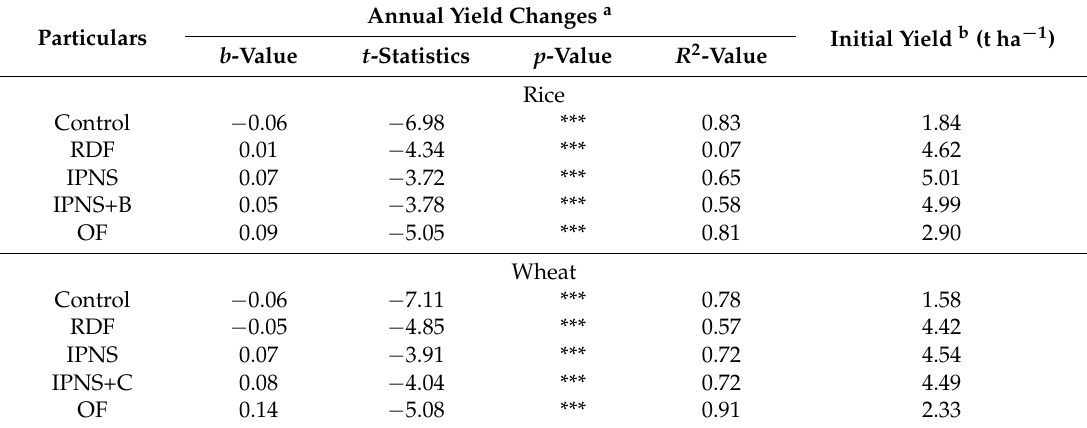
Table 3. Trends in the yields of rice and wheat in a long-term rice-wheat system under different nutrient management